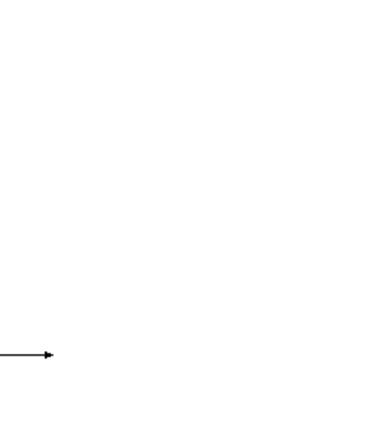
Figure 2. Viability and mortality